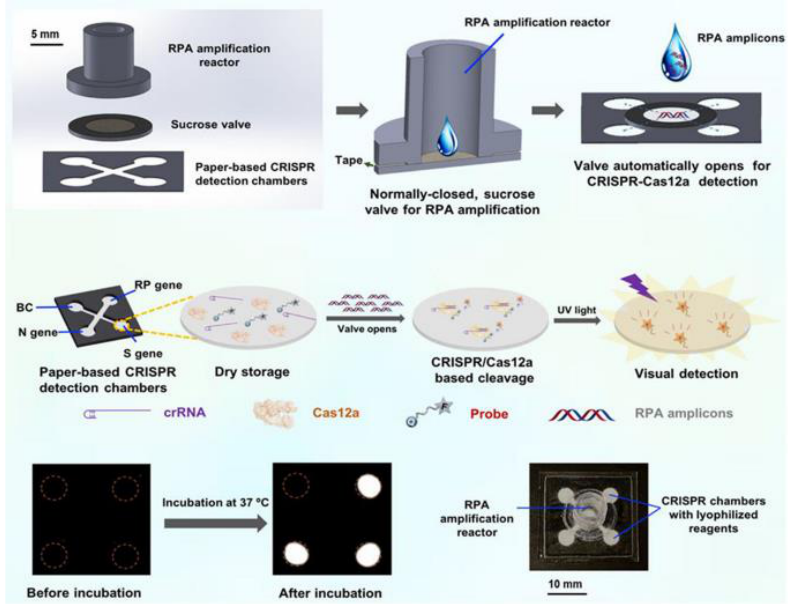
Figure 2. Schematic diagram of paper-based microfluidics for SARS-CoV-2 detection. Reproduced with permission from Li, X., Biosensors and Bioelectronics , published by Elsevier, 2021 [23]. Compared with traditional microfluidic platforms, µ PADs are more convenient to use, less expensive to manufacture, simple, and nonpolluting for post-processing. They can be performed by simple and safe combustion, but using paper as a carrier provides benefits but also has some limitations. For some samples with low surface tension, the hydrophobic zone is not necessarily hydrophobic enough and may be prone to leakage; in addition, samples tend to remain in the paper channel leading to low sample utilization; most importantly, the paper chip is still lacking in the issue of